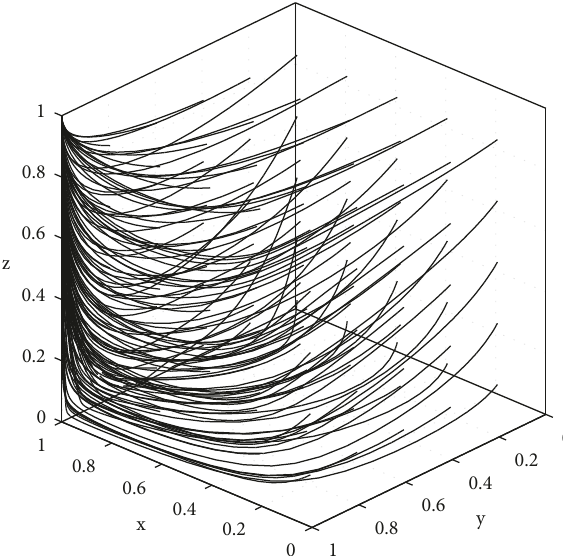
Figure 8: Dynamic evolution path of case 7.